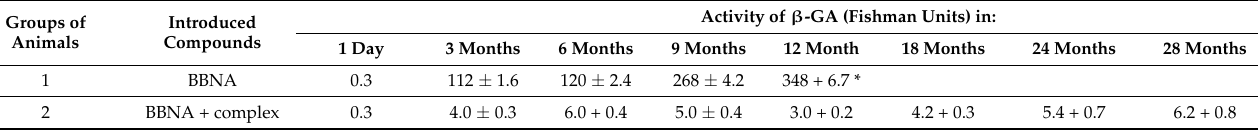
Activity of β -GA (Fishman Units)